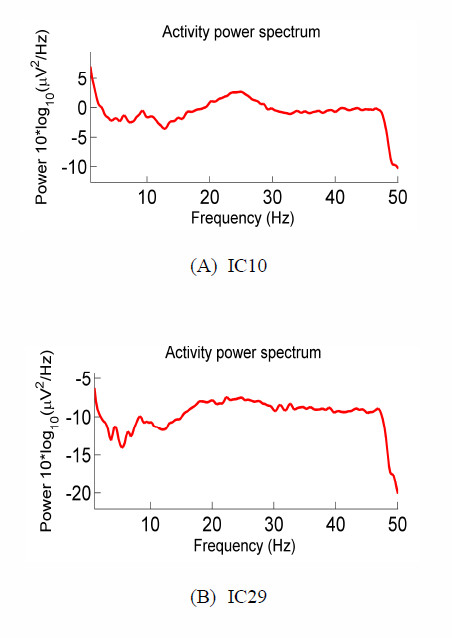
Power spectrums of EMG independent components. This figure shows the power spectrums of IC10 (A) and IC29 (B). The corresponding scalp maps are shown in Figure 6.